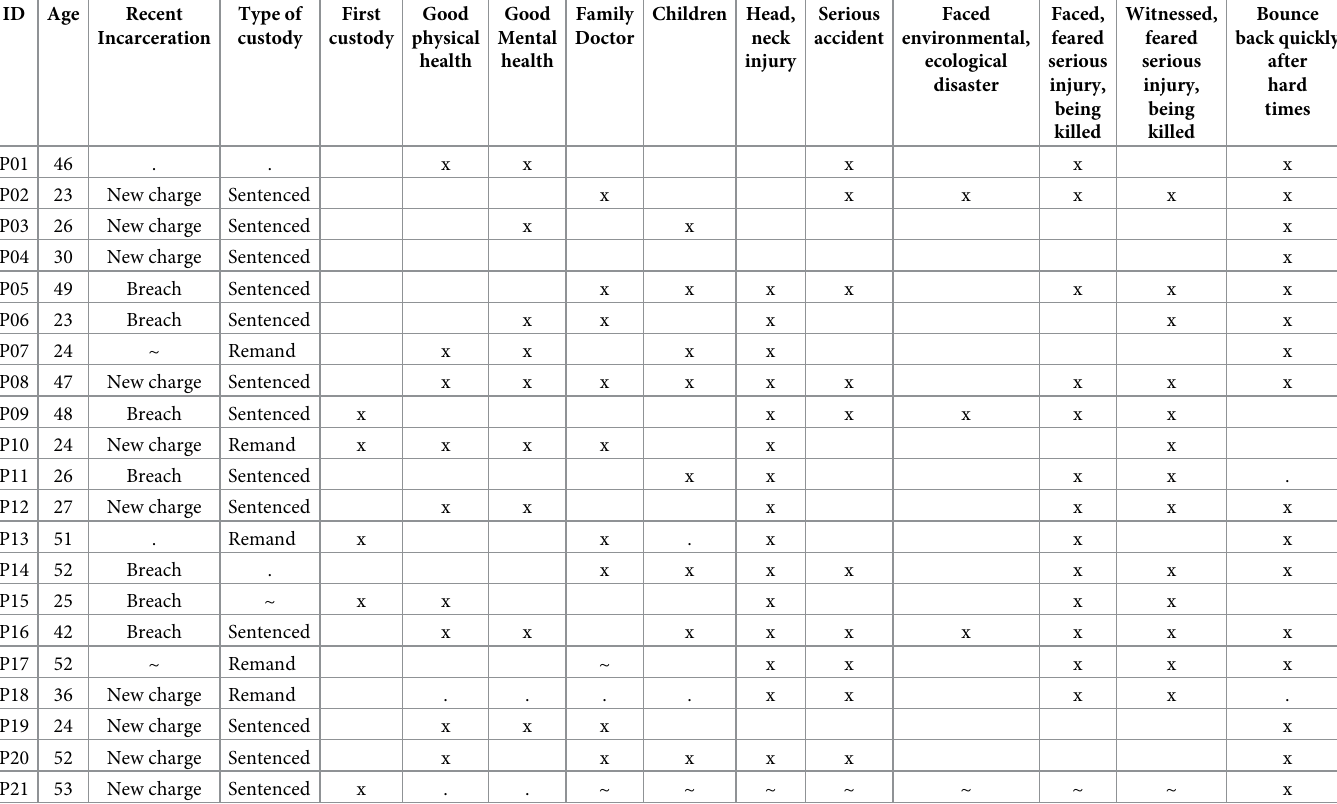
Table 2. Detailed sample characteristics on complexity (n =